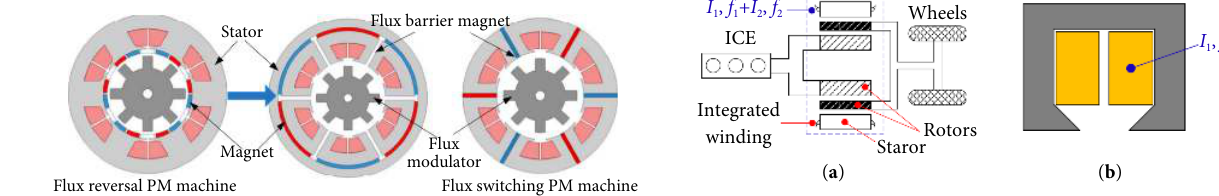
Fig. 21 Integrated winding design for the presented MP-FMM (reprinted with permission from Ref. [65], © 2020 IEEE). (a) Machine system with in- tegrated winding. (b) Coil displacement of integrated windings in